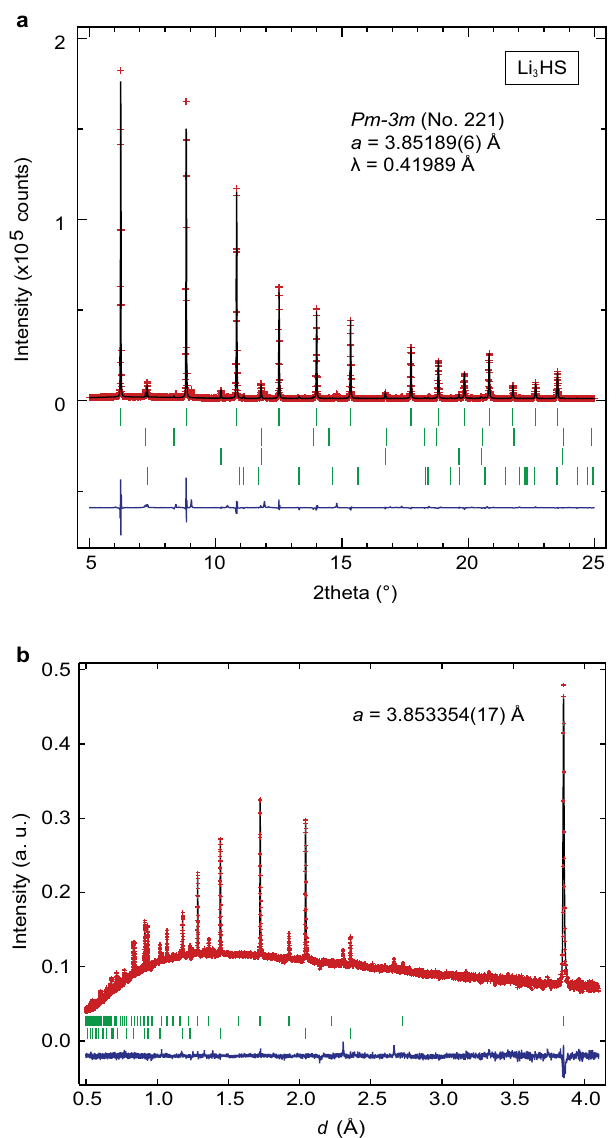
Fig. 2 Structural determination of Li 3 HS. Rietveld re fi nement of a SXRD and b ND. The red crosses, black solid line, blue solid line, and green dashes denote, respectively, the observed, calculated, difference intensities, and calculated Bragg re fl ections (from top to bottom: Li 3 HS, Li 2 S, LiH, BN in a ; Li 3 HS, LiH in b